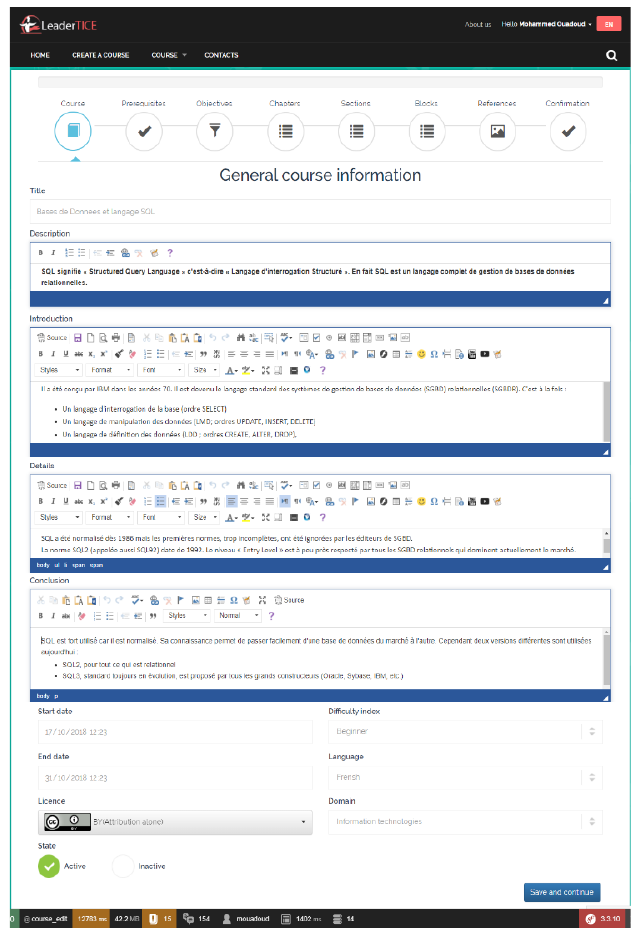
Fig. 3. General information interface of the course developed by the NoSQL